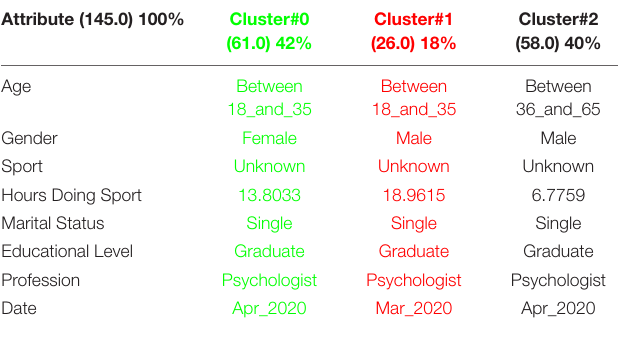
TABLE 14 | 3 clusters AF5 analysis for March to May